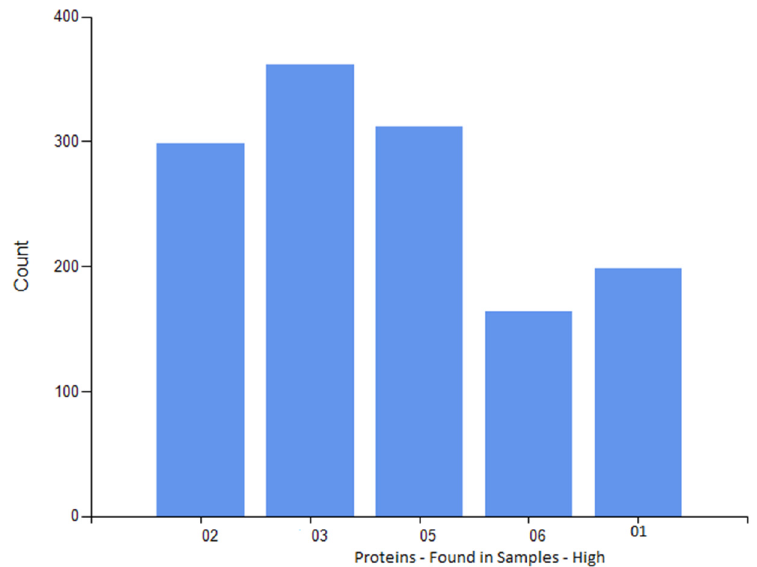
Figure 2. Distribution of the high-abundance proteins for O. vulgaris mucus samples (O1, O2, O3, O5, and O6) determined by LFQ.